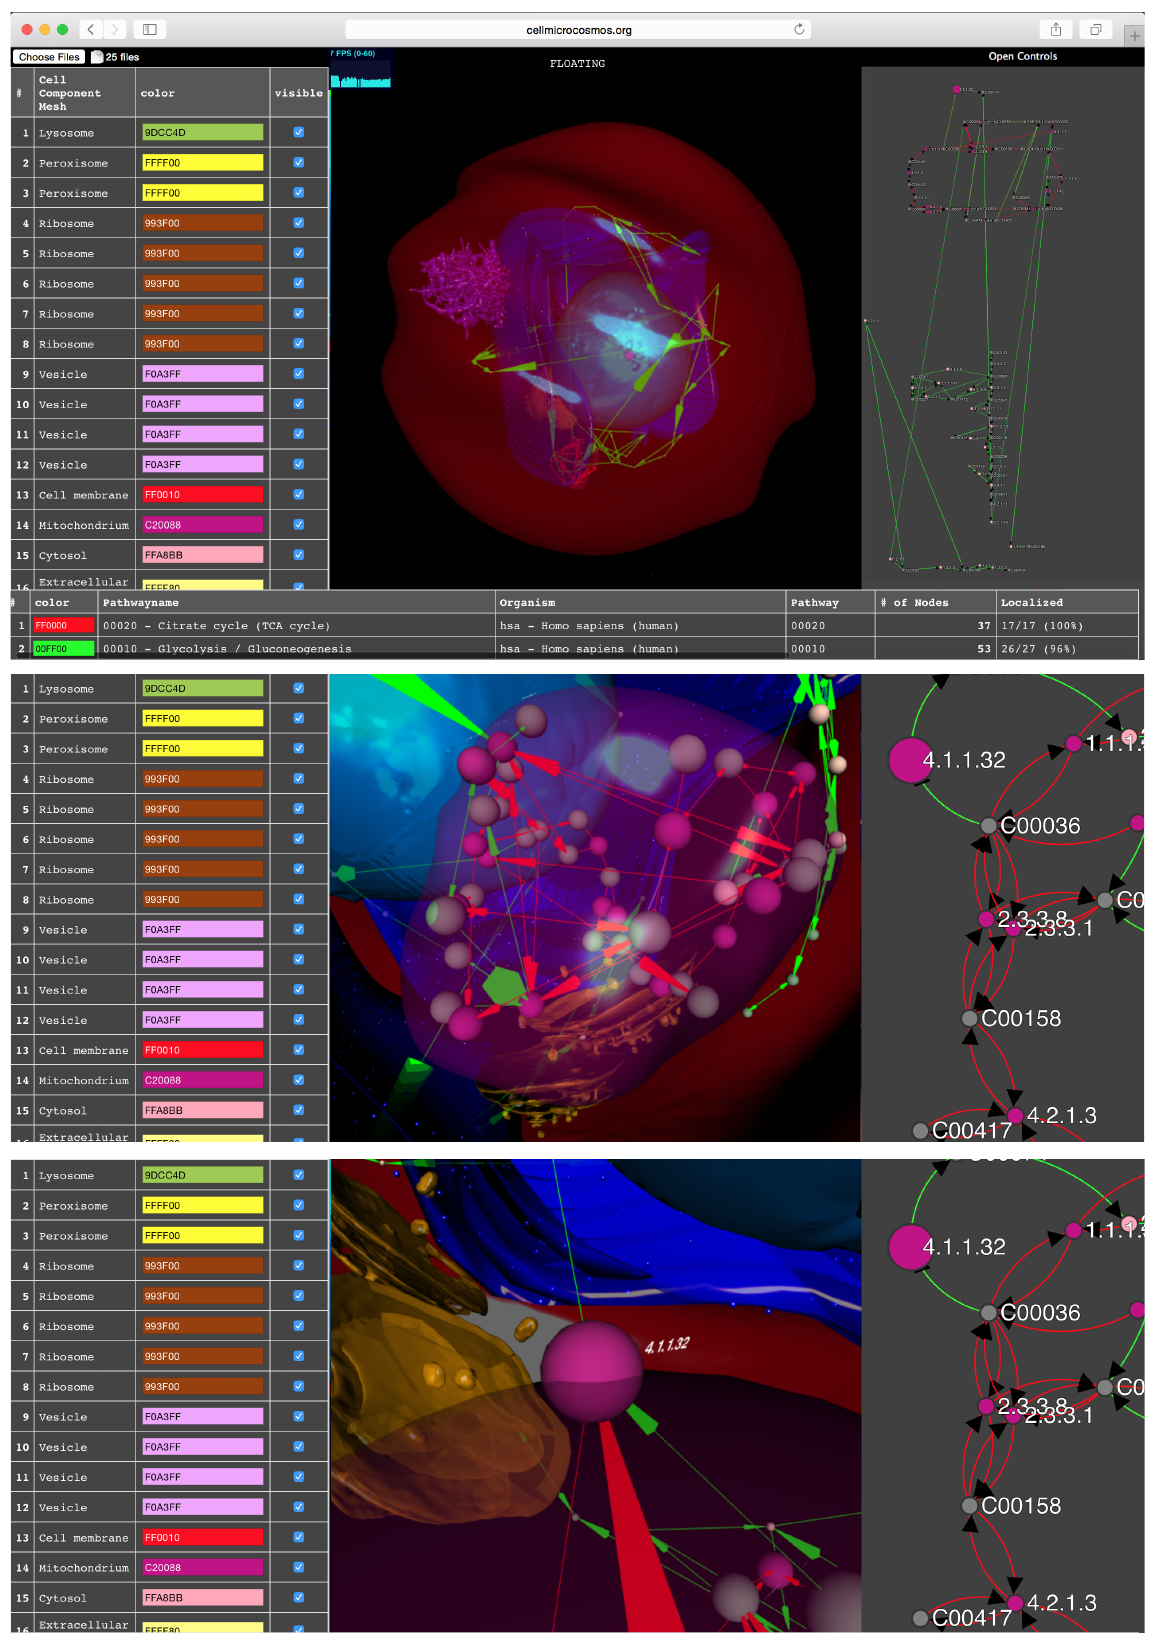
Figure 3: CmPIweb visualizing the citrate cycle and the glycolysis pathway inside an animal cell. Top: The complete cell is shown in the centre and on the left side the complete pathway is shown. Centre: The mitochondrion is focused which contains the citrate cycle (red), whereas the glycolysis is located in the cytosol (yellow); Bottom: Focusing at the enzyme 4.1.1.32, which is part of the citrate cycle as well as the glycolysis pathway and located on the surface of the